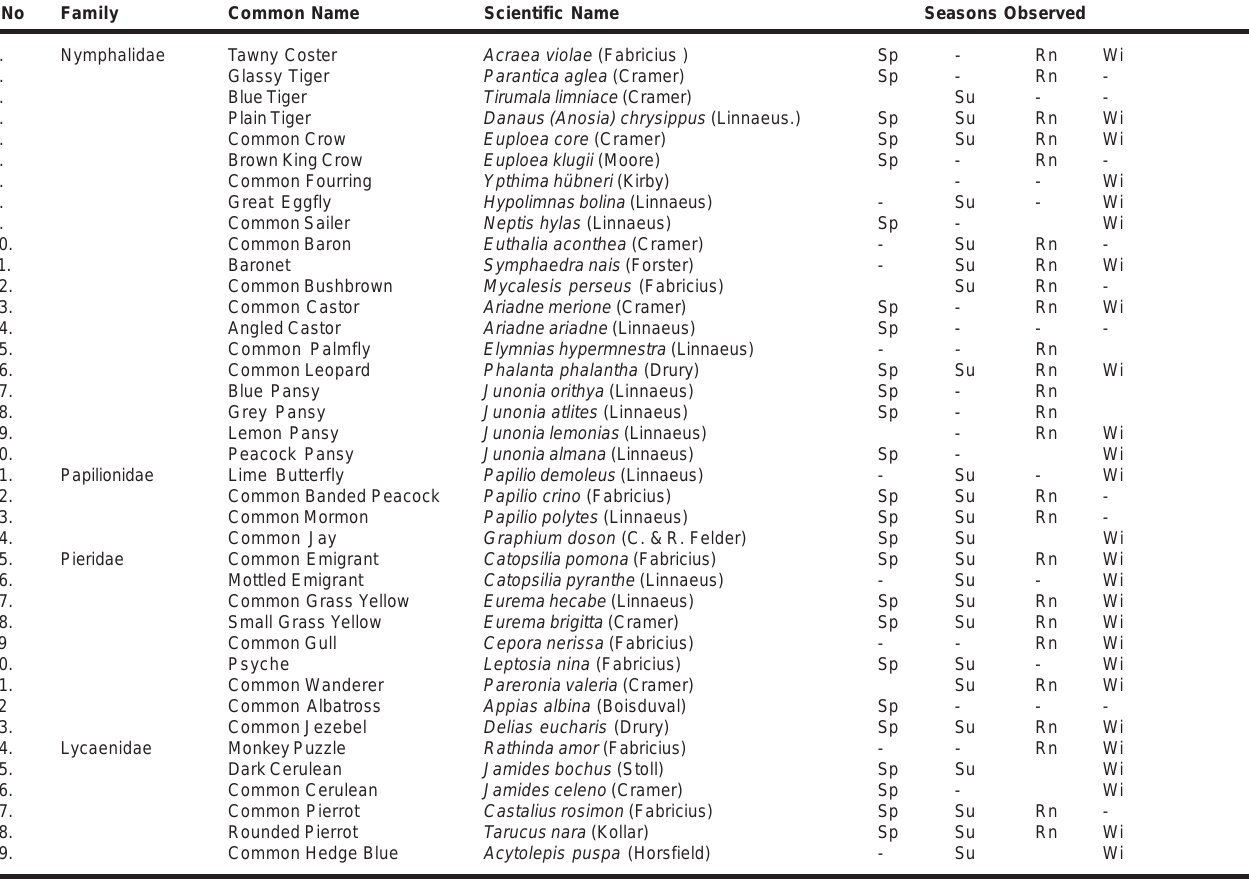
Table 1. Butterflies recorded at Dalma Wildlife Sanctuary and their seasonal distribution SNo